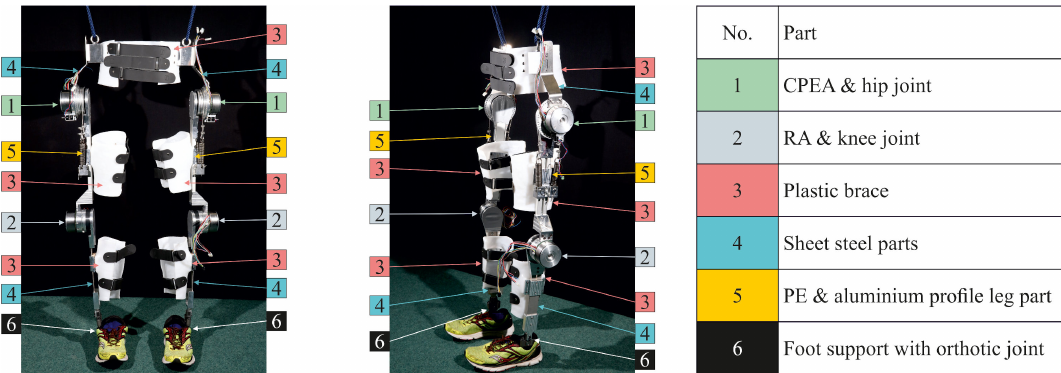
Figure 4. Photos of the exoskeleton prototype: frontal and oblique